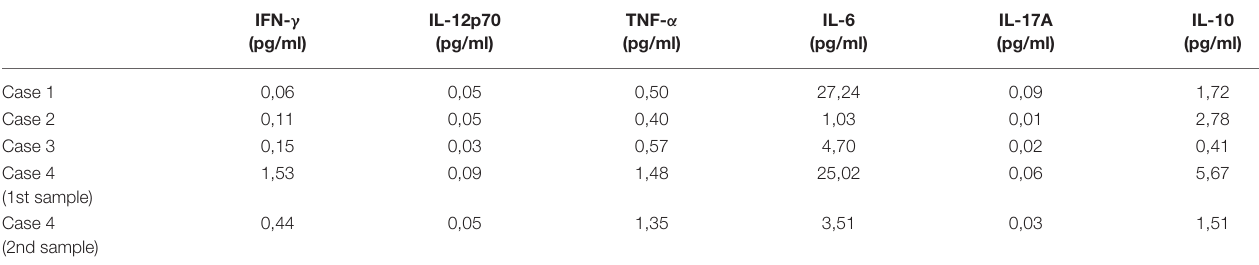
TABLE 2 | Cytokine levels in cerebrospinal fluid.